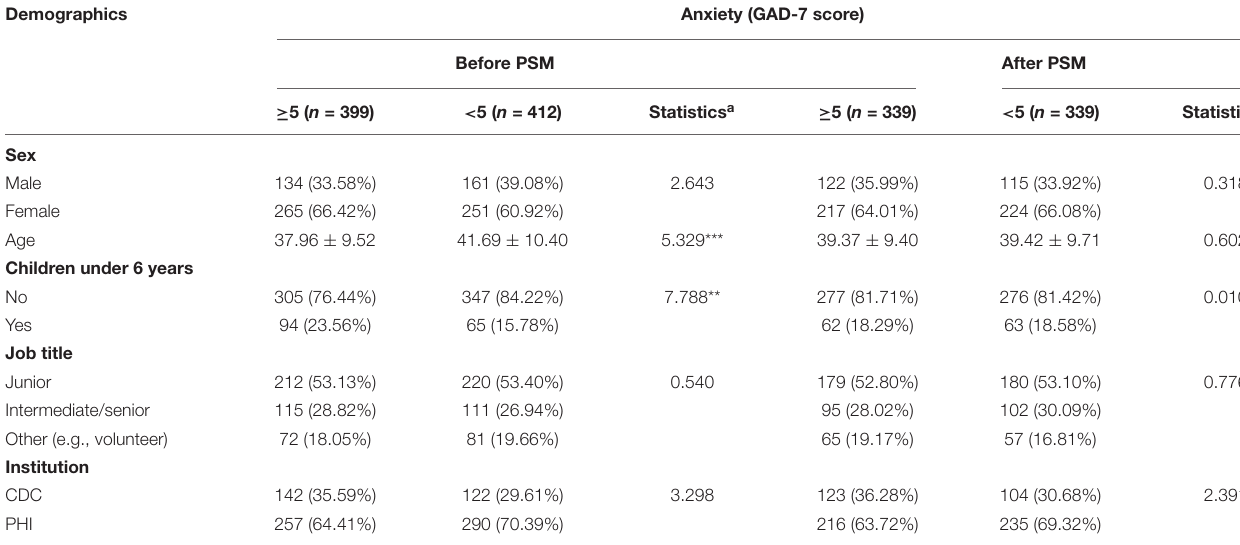
TABLE 1 | Demographic characteristics of the anxiety groups before and after PSM ( n , %).